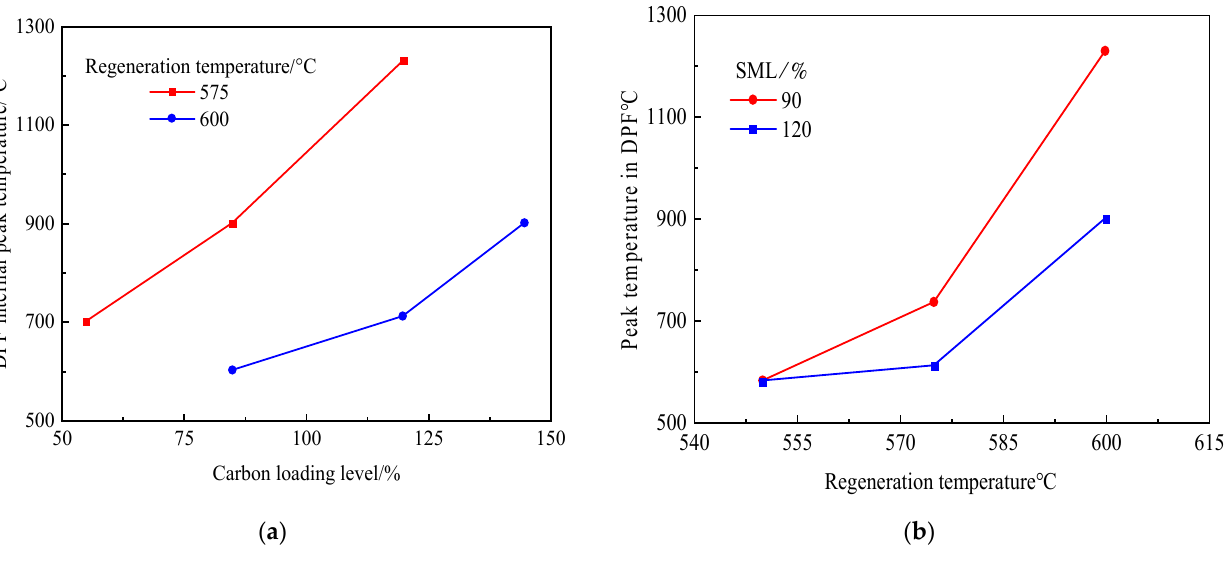
Figure 11. DPF peak temperature vs. soot load level and regeneration temperature. ( a ) Carbon loads; ( b ) Regeneration temperature.